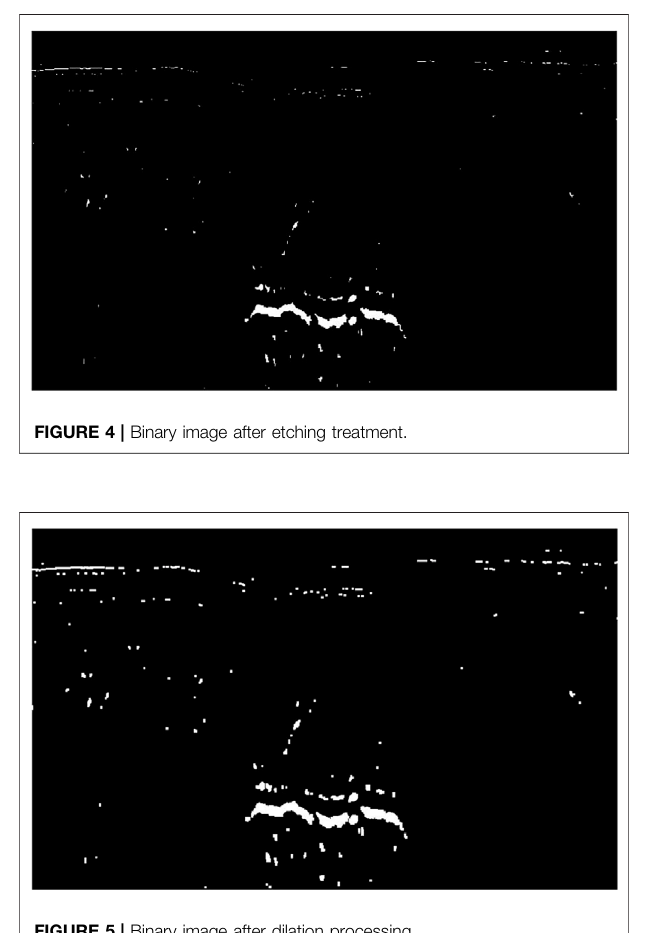
FIGURE 5 | Binary image after dilation processing.